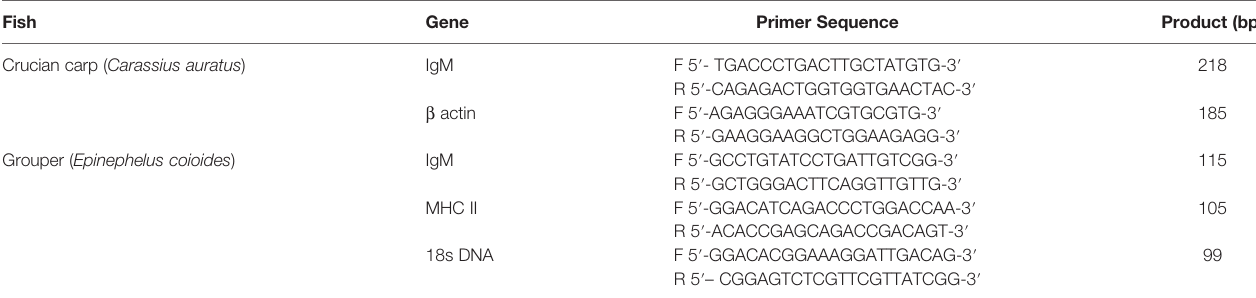
TABLE 1 | Primers used for